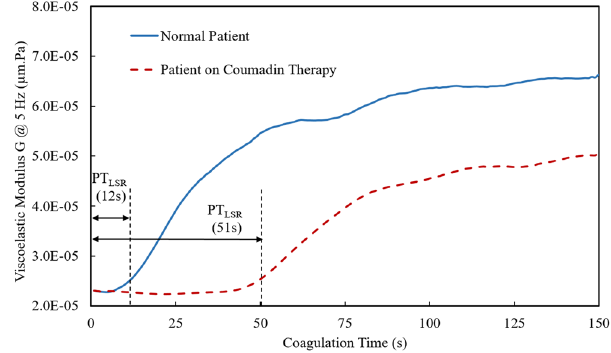
Figure 2. Viscoelastic modulus, G, at 5 Hz measured by the LSR sensor is plotted as a function of coagulation time from blood samples obtained from a normal patient (with reported normal laboratory PT/INR value) and a patient on Coumadin medication. The G trace measured in real-time during coagulation was analyzed to estimate the PT and INR values. The blood sample from normal patient showed shorter PT LSR value (12 s) in comparison to the blood sample from the patient on Coumadin therapy (51 s). The corresponding PT Lab values obtained from standard laboratory testing were 14 s and 43 s for the normal and Coumadin treated patient respectively.